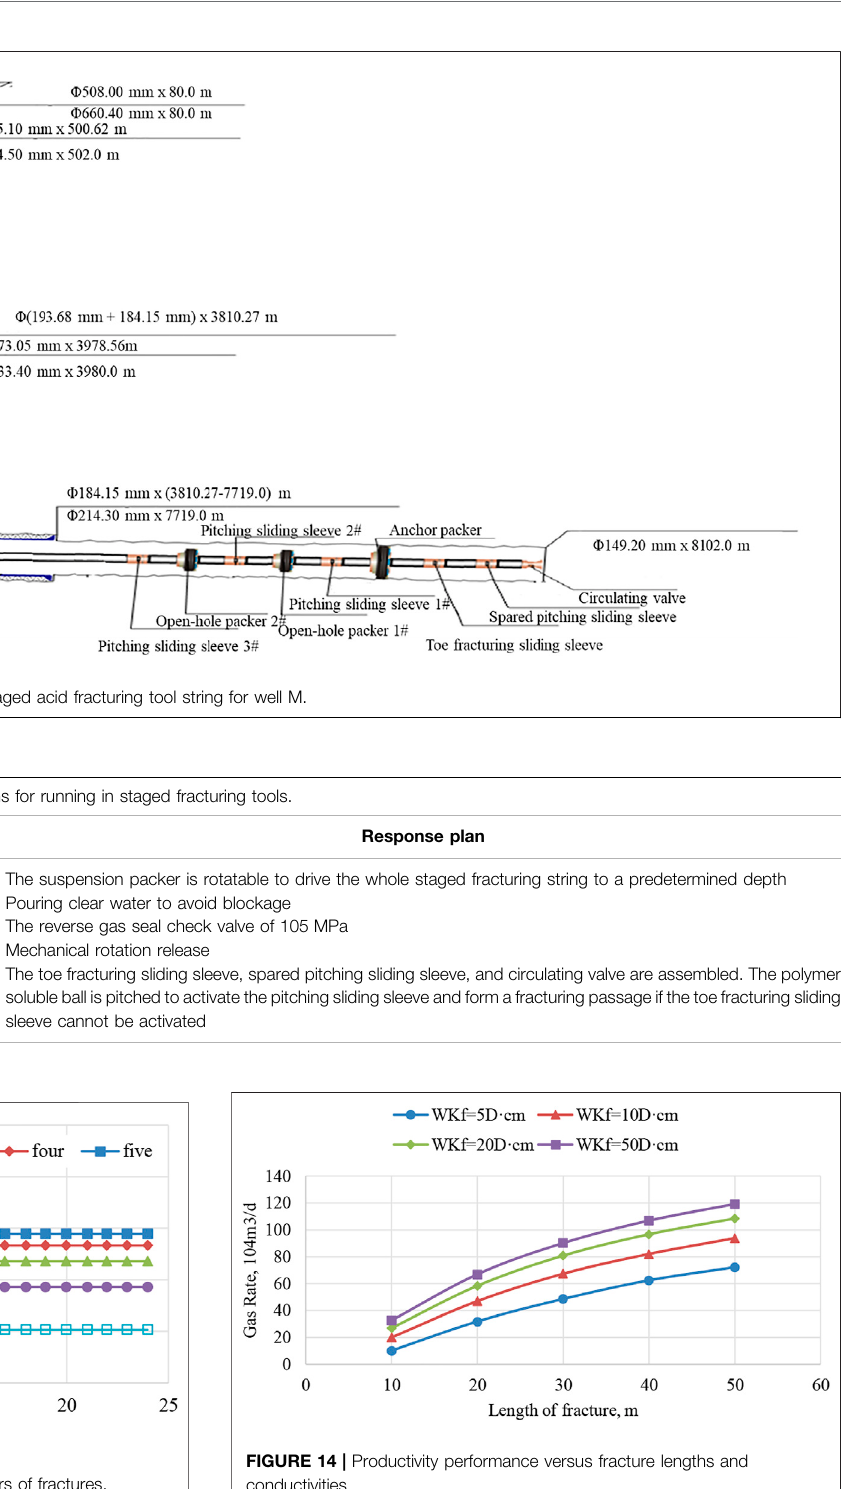
FIGURE 13 | Productivity performance versus numbers of fractures.